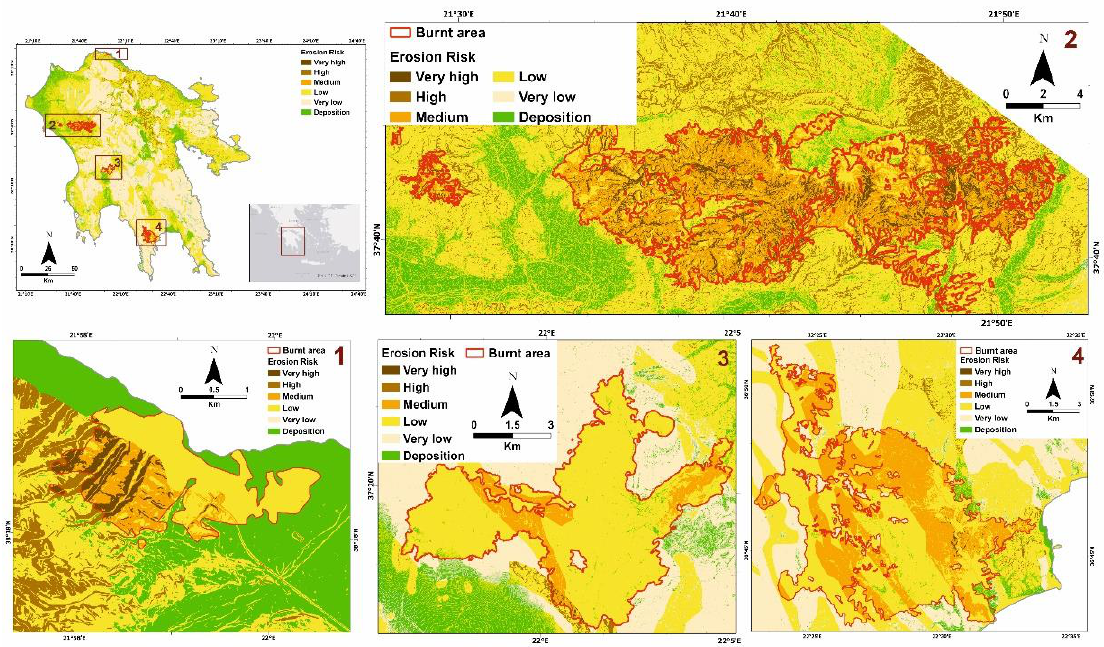
Figure 11. Results of erosion risk in the fire-affected area of the Peloponnese using a Boolean logic- based model. The map on the top right shows the location of the investigated areas the numbers corresponding to the other four individual maps, where ( 1 ) is Aigialeia, ( 2 ) is Ancient Olympia, ( 3 ) is Diavolitsi and ( 4 ) is Eastern Mani.